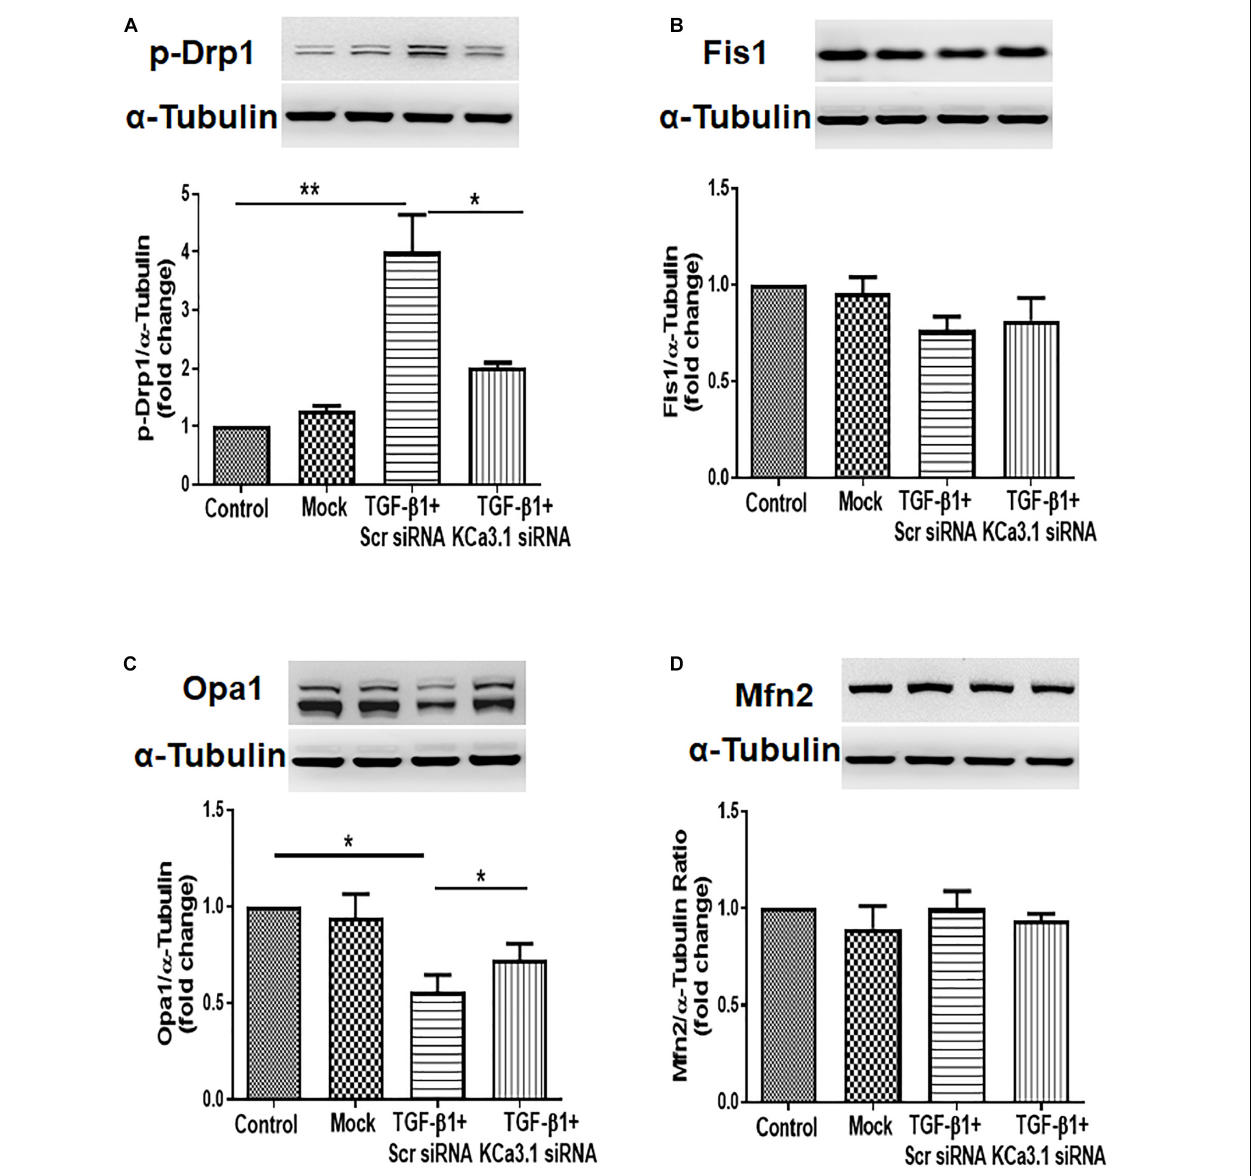
FIGURE 2 | KCa3.1 gene silencing attenuated TGF- β 1-induced increased fission and suppressed fusion in HK2 cells. Mitochondrial pro-fission proteins (Drp1 and Fis1) and pro-fusion mediators (Opa1 and Mfn2) were examined by western blotting. Western blot analyses revealed an increased expression of Drp1 (A) and a reduced expression of Opa1 (C) in TGF- β 1-induced HK2 cells, which were reversed by KCa3.1 gene silencing. There were no changes in the expression of Fis1 (B) and Mfn2 under TGF- β 1 stimulation (D) . Results are presented as mean ± SEM. * P < 0.05, ** P < 0.01, N =